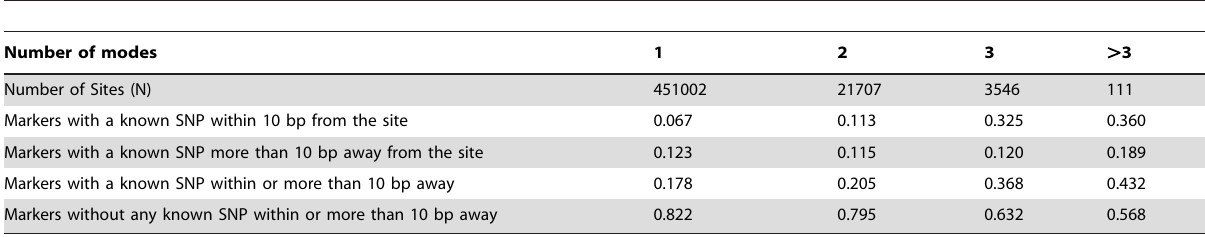
Table 1. Number of modes in the distribution of DNA methylation for each